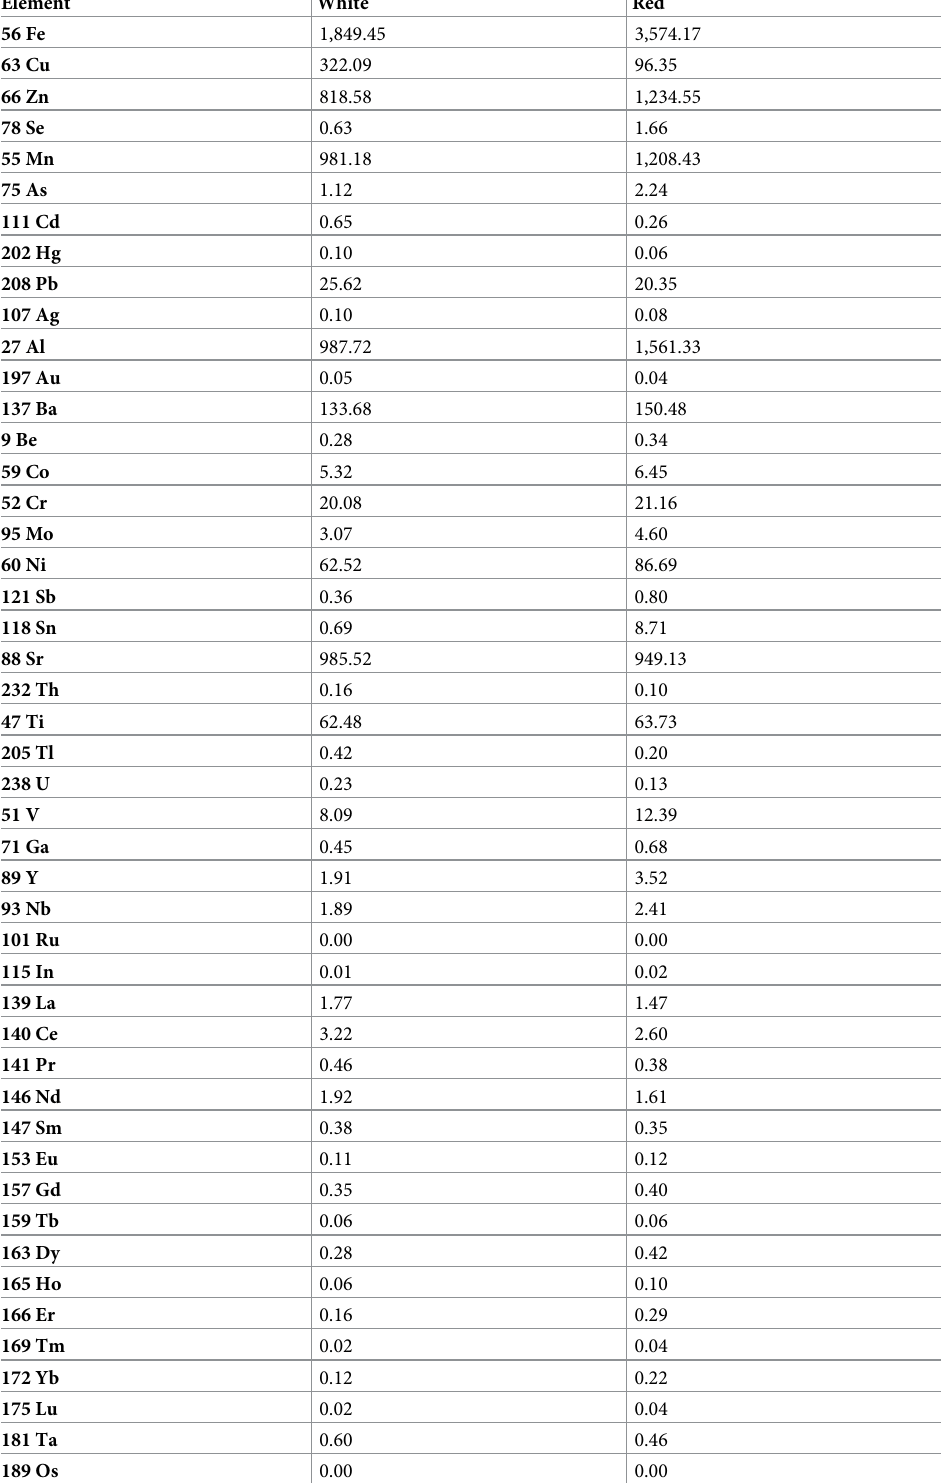
Table 4. Average concentration in ng/ l of each element in the two wine